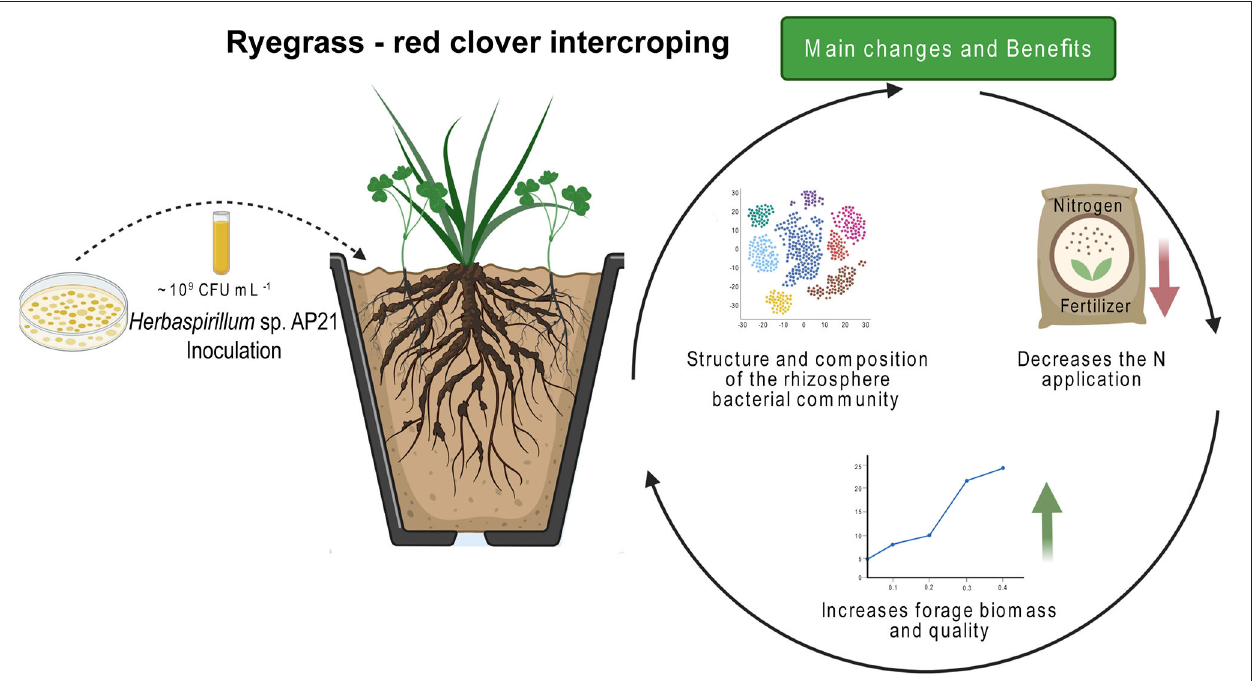
FIGURE 5 | Inoculation of the intercropping system with Herbaspirillum sp. AP21 brought about changes in the microbial community, which positively correlated with an increase in plant growth and quality. The concomitant use of AP21 and 50% of the fertilization doses phenocopied the complete fertilization control. The use of this technology thus reduces the use of N fertilizers, improving the economical and environmental sustainability of the